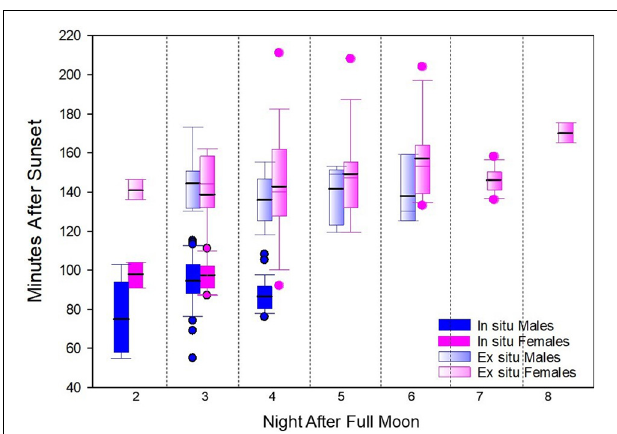
FIGURE 4 | Spawn times in minutes after sunset of in situ and ex situ Dendrogyra cylindrus separated by night of spawning. Box plot metrics include: mean (black line), 25th–75th percentile (box), 10th–90th percentile (whiskers), and outliers (dots). Ex situ corals released later in the evening and on a greater number of nights than in situ corals.